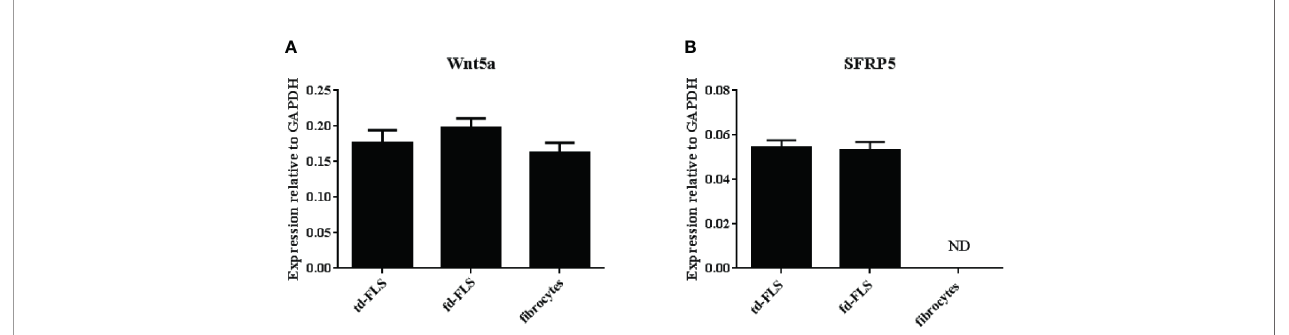
FIGURE 3 | Expression of Wnt5a and SFRP5 in td-FLS, fd-FLS and fi brocytes during RA. Wnt5a gene level pro fi les in the three cell types by quantitative RT-PCR: No signi fi cant differences were found in mRNA levels (A) . SFRP5 mRNA expression: SFRP5 was expressed in td-FLS and fd-FLS but not in fi brocytes (n=3-4) (B) . ND, Not detected. Results are shown as the mean